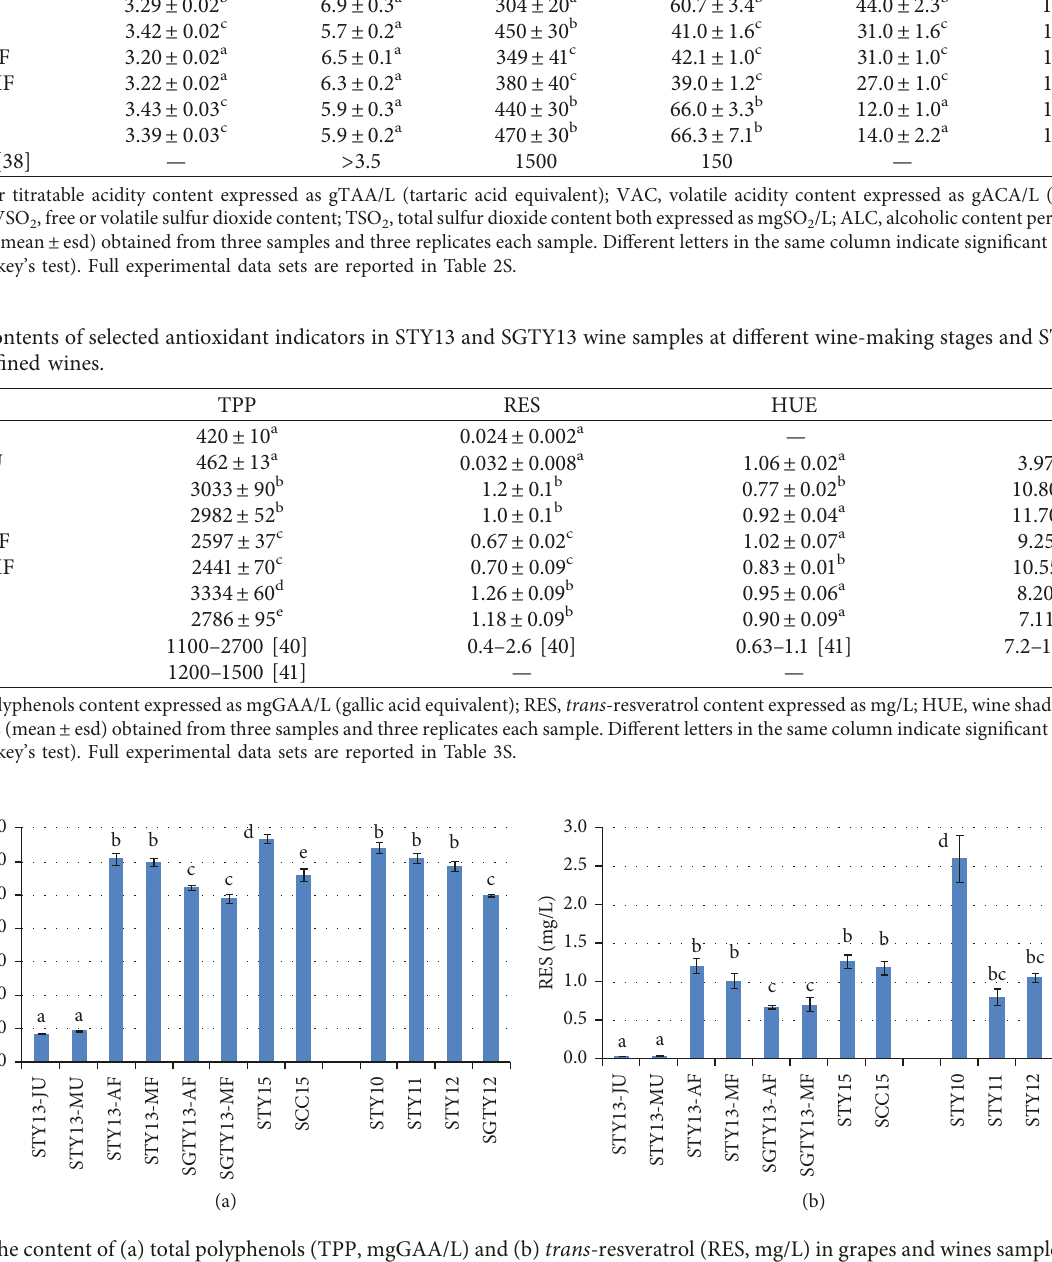
Table 2: Selected fermentation parameters in STY13 and SGTY13 wine samples at different wine-making stages and STY15 and SCCY15 refined wines. STY13-AF STY13-MF